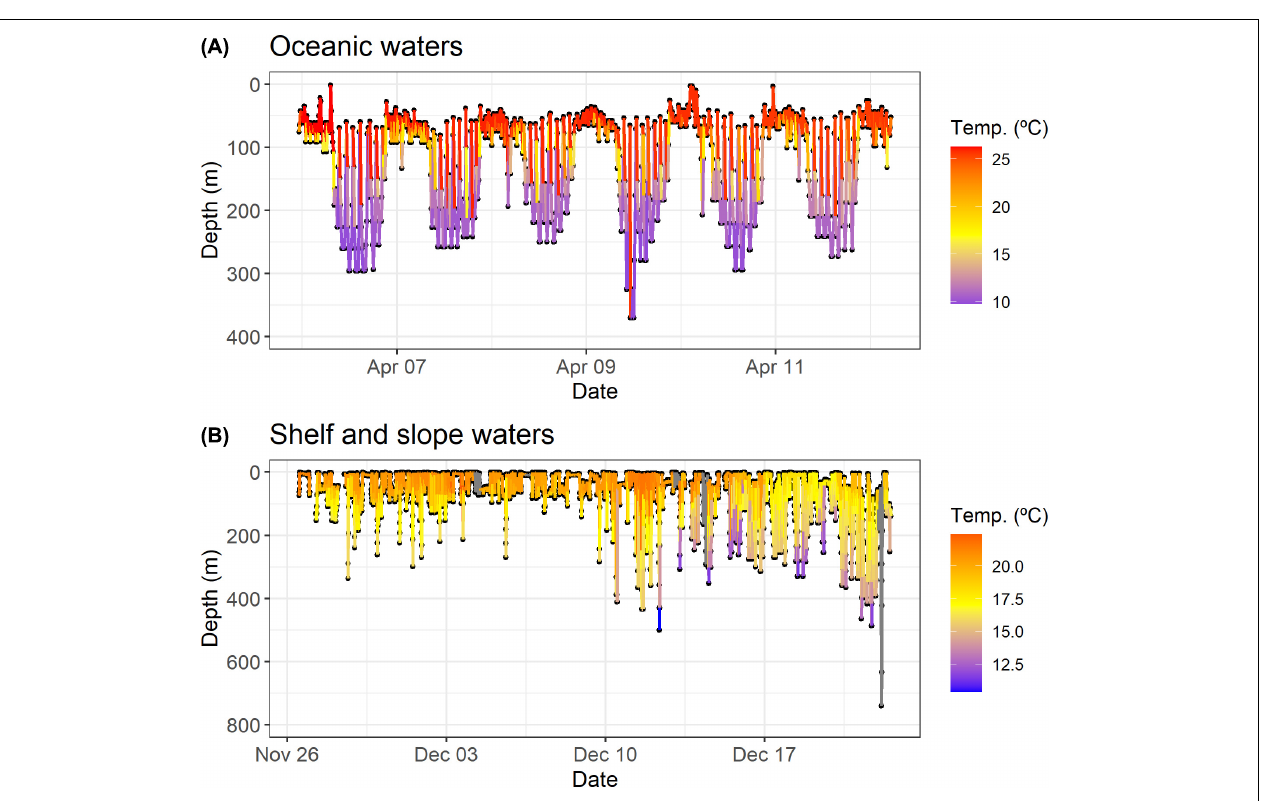
behavior with deeper dives occurring primarily during